Question: Express in one sentence what the figure is showing.
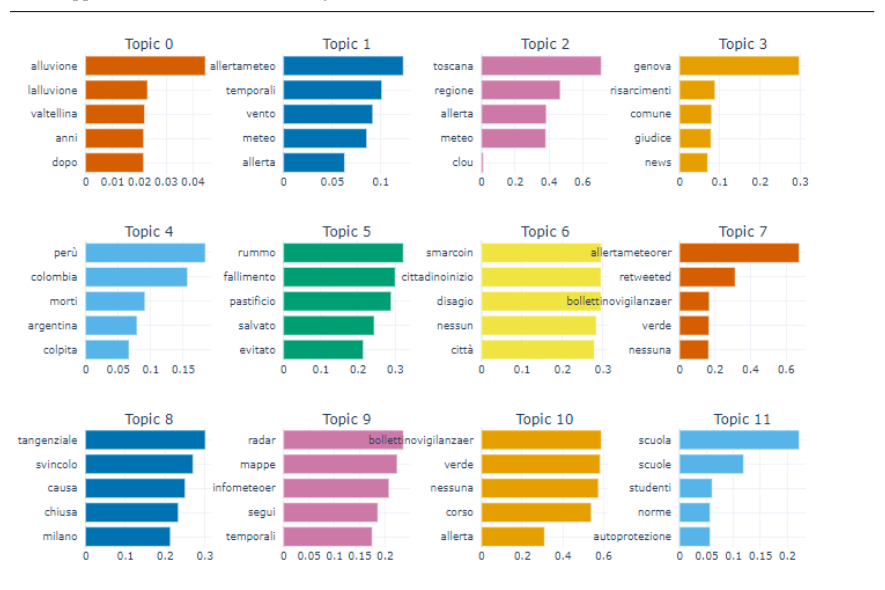
Answer: provides a summary of the top 12 topics, along with the word scores, extracted from the complete set of relevant tweets. The length of the bars shows the score of each keyword relevant to the topic, thus, a longer bar means high importance/relevance of the keyword to the topic. For instance, the keywords ”alluvione” and ”llaluvione” are the most